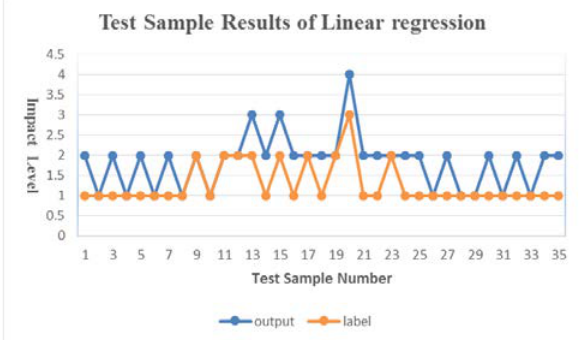
Figure 4. Accuracy evaluation of linear regression model